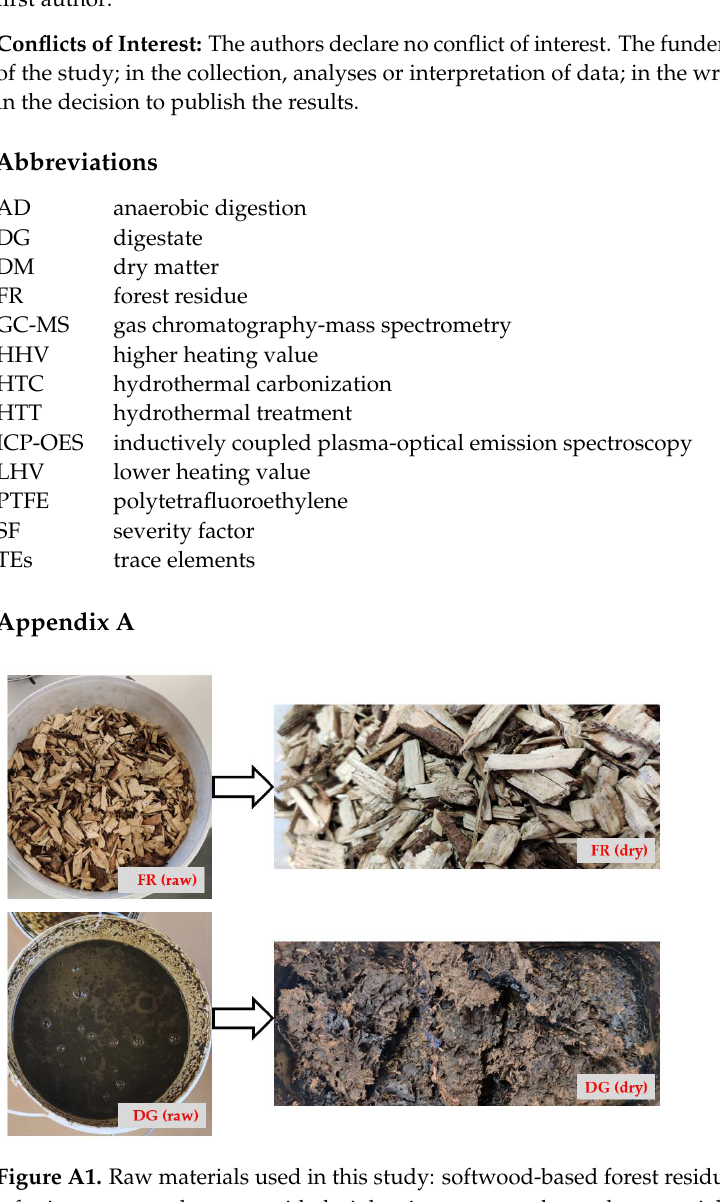
Figure A2. H/C and O/C ratios of the digestate and forest residue for raw and hydrothermally treated solids (generated with a temperature of 130, 150 or 170 °C and with a holding time of 30, 60 or 90 min).